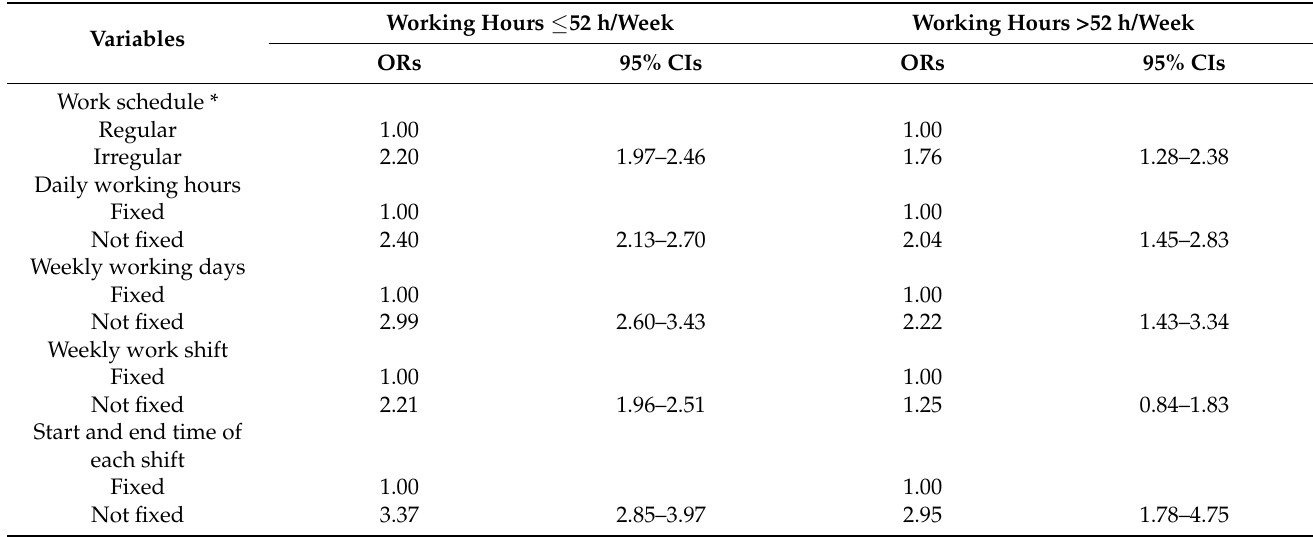
Table 4. Odds ratios and 95% confidence intervals for moderate sleep disturbance based on working hour stratification analysis.